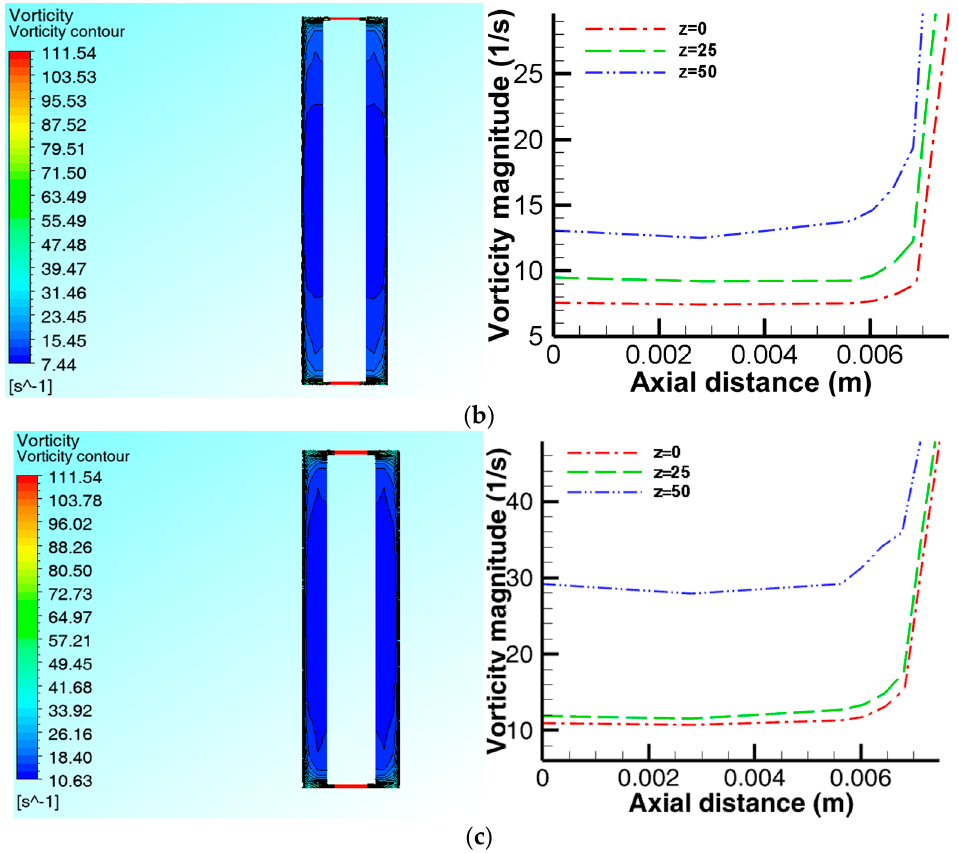
Figure 8. Reactor cross-sections showing the vorticity contours and axial vorticity magnitude profiles along three horizontal lines on X-Z plane at N = 70 rpm with the RNG model: ( a ) y = 0; ( b ) y = 0.025; ( c ) y = 0.045.